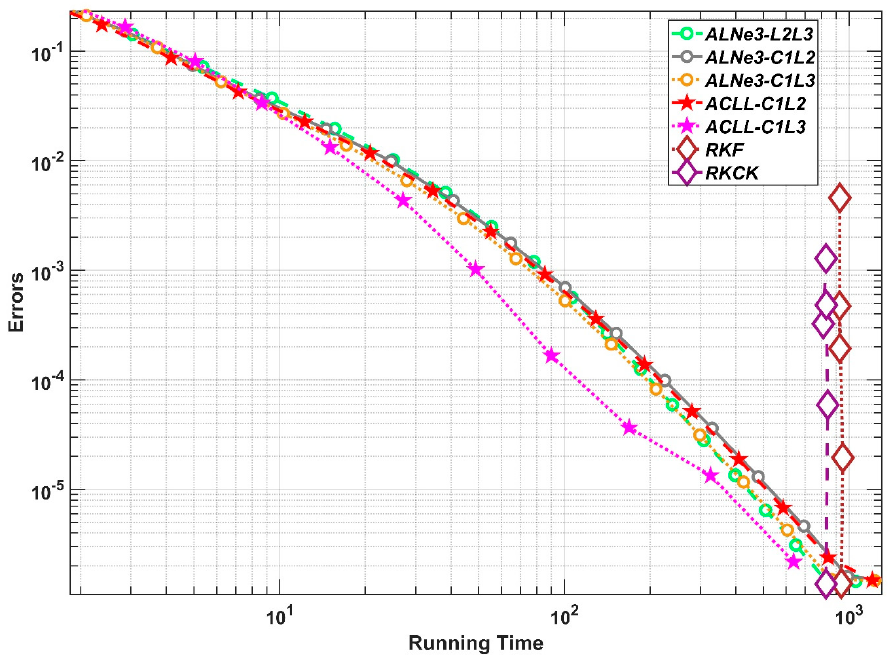
Figure 11. The 𝐿 (cid:2998) errors as a function of the running times in Experiment 1. Figure 11. The L ∞ errors as a function of the running times in Experiment 1. Algorithms 2023 , 16 , x FOR PEER REVIEW